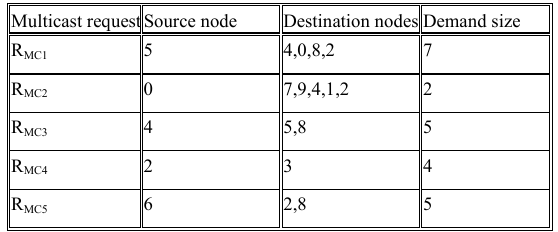
TABLE 6. The given multicast requests in light-trail networks for scenario 2